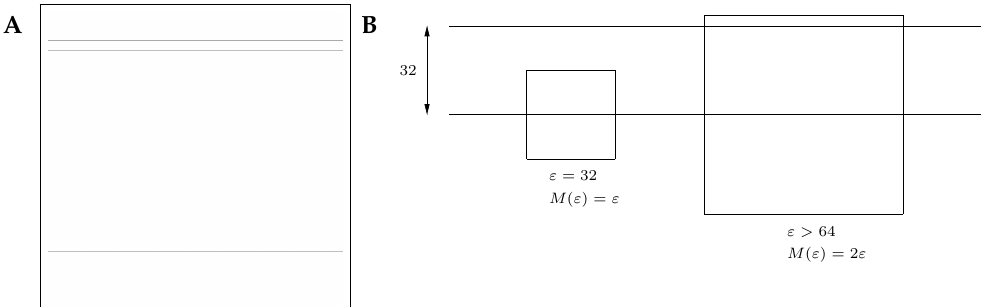
Figure 4. A sample image constructed to verify the results of Section 5.1. ( A ) The image contains three non-uniformly spaced lines. The top two lines are spaced 32 pixels apart and the bottom two lines are spaced 700 pixels apart. ( B ) Since the generalized sandbox method requires that boxes are centred on individual pixels, the transition from M ( ε ) = ε to M ( ε ) = 2 ε occurs when ε > 64. A minimum box size of 3 pixels is used, and the maximum box size is set to 50